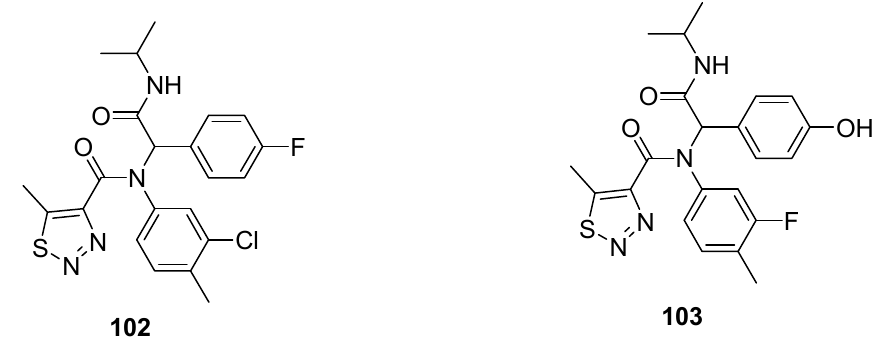
Figure 10. 1,2,3-Thiadiazole scaffolds 102 and 103 with anti-TMV activity.